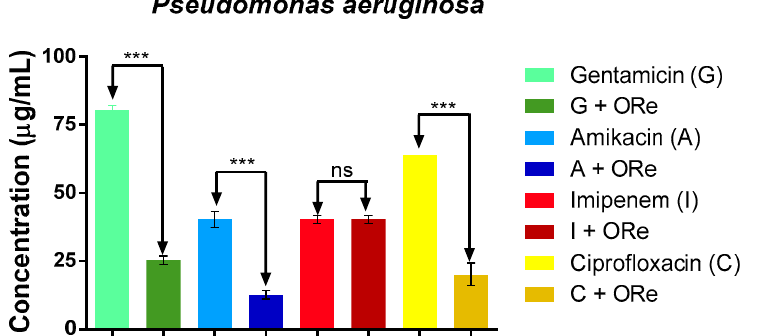
Figure 5. Minimum inhibitory concentration of antibiotics in the presence and absence of R. echinus leaf essential oil for Pseudomonas aeruginosa . ORe = R. echinus leaf essential oil. Statistical analysis: one-way ANOVA followed by Bonferroni post-hoc test. *** p < 0.001 indicates significant difference when R. echinus leaf essential oil was added to the medium. ns, not significant; G = gentamicin, A = amikacin, I = imipenem, C = ciprofloxacin. Data show mean + SEM from three independent experiments performed in triplicate.